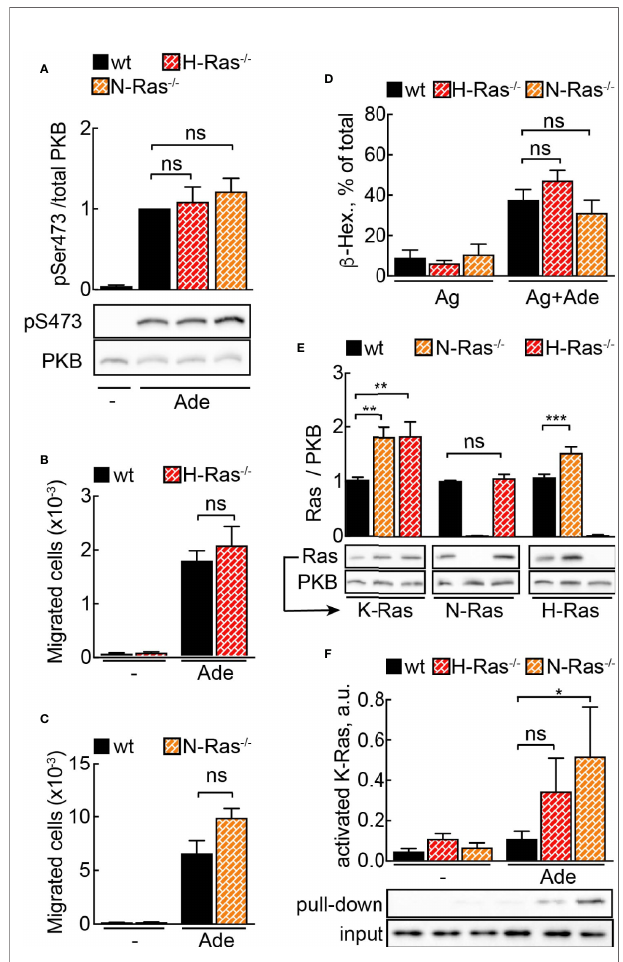
FIGURE 2 | N- or H-Ras deletion without effect on PI3K g signaling due to Ras isoform compensation. (A) WT, H-Ras − / − and N-Ras − / − BMMCs were starved in IL-3-free medium containing 2% FCS for 4 h and stimulated with 2 µM adenosine for 2 min at 37°C. Phosphorylation of PKB at Ser473 was determined by Western blotting and normalized to the total PKB levels (n = 8 – 12). (B, C) Migration of wild-type (WT), H-Ras − / − and N-Ras − / − cells was assessed in Transwell chambers for 6 h at 37°C with 2 mM Ade in the lower well (n = 5 – 8). (D) Wild-type (WT), H-Ras − / − , and N-Ras − / − BMMCs were loaded overnight with anti-DNP IgE (100 ng/ml) followed by stimulation with DNP-HSA (antigen, Ag, 2 ng/ml) alone or in combination with 2 µM Ade. Release of b -Hexosaminidase was quanti fi ed 20 min after stimulation (n = 3 – 9). (E) K-Ras, N-Ras and H-Ras proteins were detected in the lysates from WT, N-Ras − / − or H-Ras − / − BMMCs by Western blotting using isoform-speci fi c antibodies and normalized to the corresponding protein amount in WT cells (n = 8 – 15). (F) WT, N-Ras − / − and H-Ras − / − BMMCs were starved in IL-3-free medium containing 2% FCS for 4 h and stimulated with 4 µM Ade for 1 min at 37°C. Active Ras was pulled down from the lysates using GST-tagged Ras binding domain of Raf1A protein, detected by Western blotting with isoform- speci fi c Ras antibodies and presented as a percentage of the total amount of the corresponding Ras isoform in the lysate used for the pull-down experiment (n = 3 – 9). Statistical analysis was performed with one-way ANOVA for (A – E) , and Student ’ s t-test for (F)